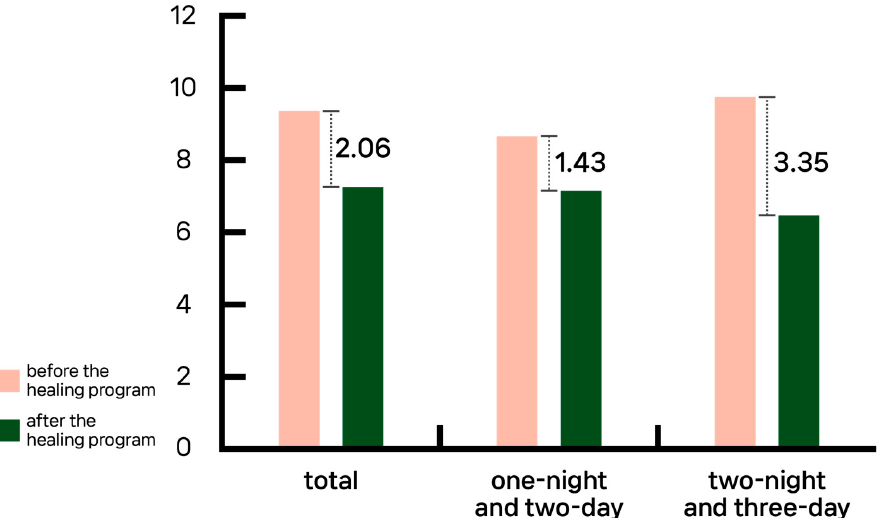
11 of 19 Figure 5. Results of subdomains for K-PSI-SF during 2018–2021. 3.4. Comparison of the Effects between the One-Night and Two-Day Program and the Two-Night and Three-Day Program The effects of the number of days in the forest healing program on the psychological changes to the children and caregivers and on the forest healing effects were examined. From 2018 to 2020, the program offered one-night and two-day programs; in 2021, two-